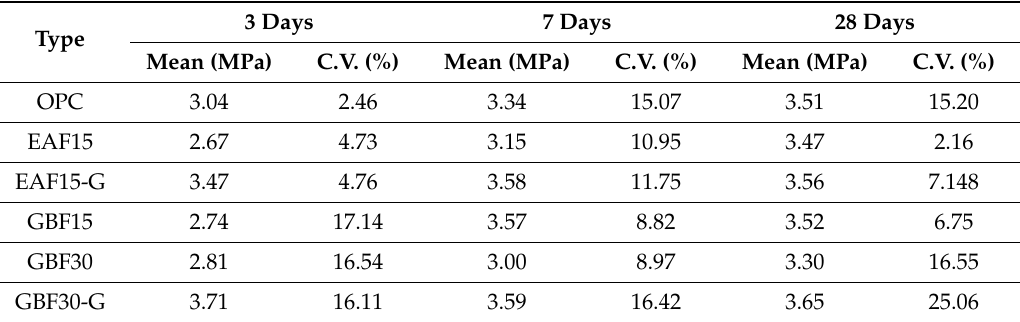
Table 6. Results of split-cylinder tensile strength. Figure 5. Compressive strength. ( a ) Results of EAF series and ( b ) results of GBF series.